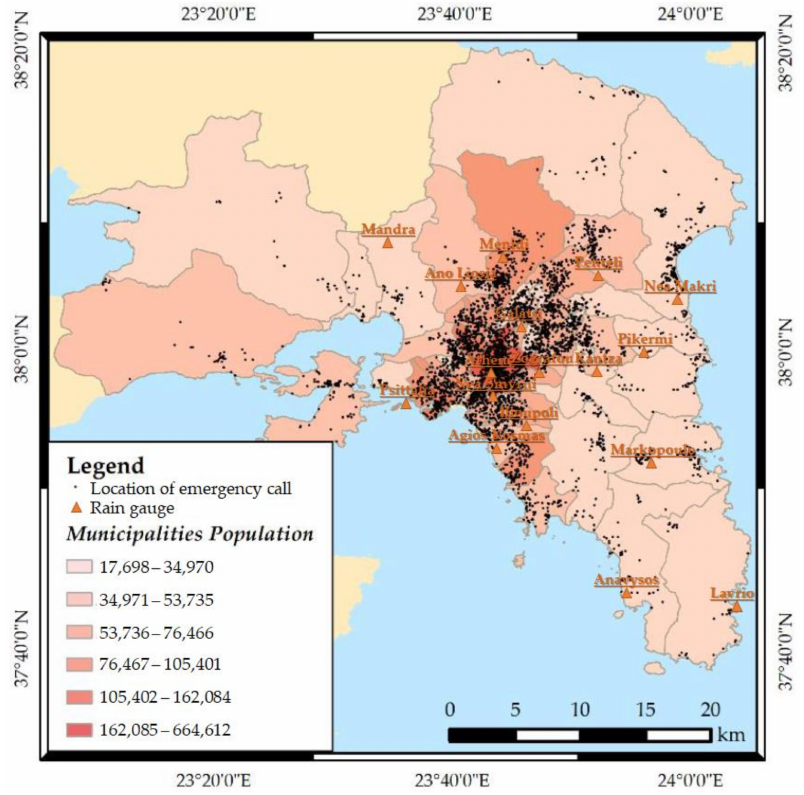
Figure 1. The study area of Attica region with the locations of rain gauges and emergency